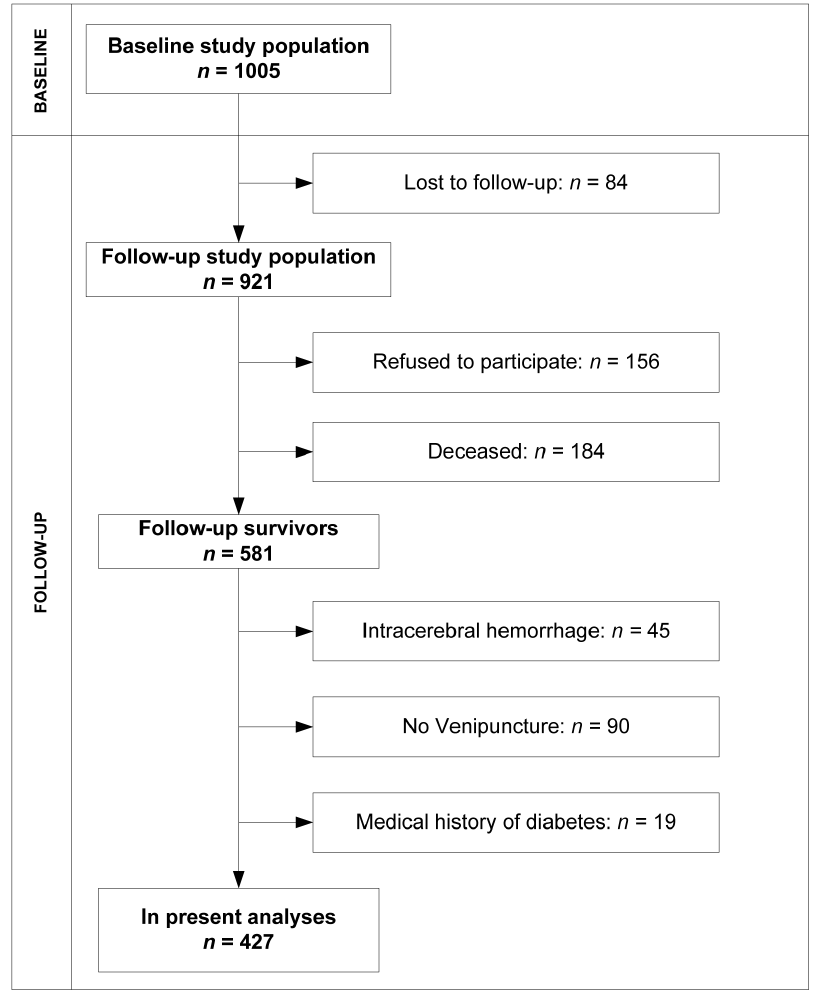
Figure 1. Flowchart of the study population.